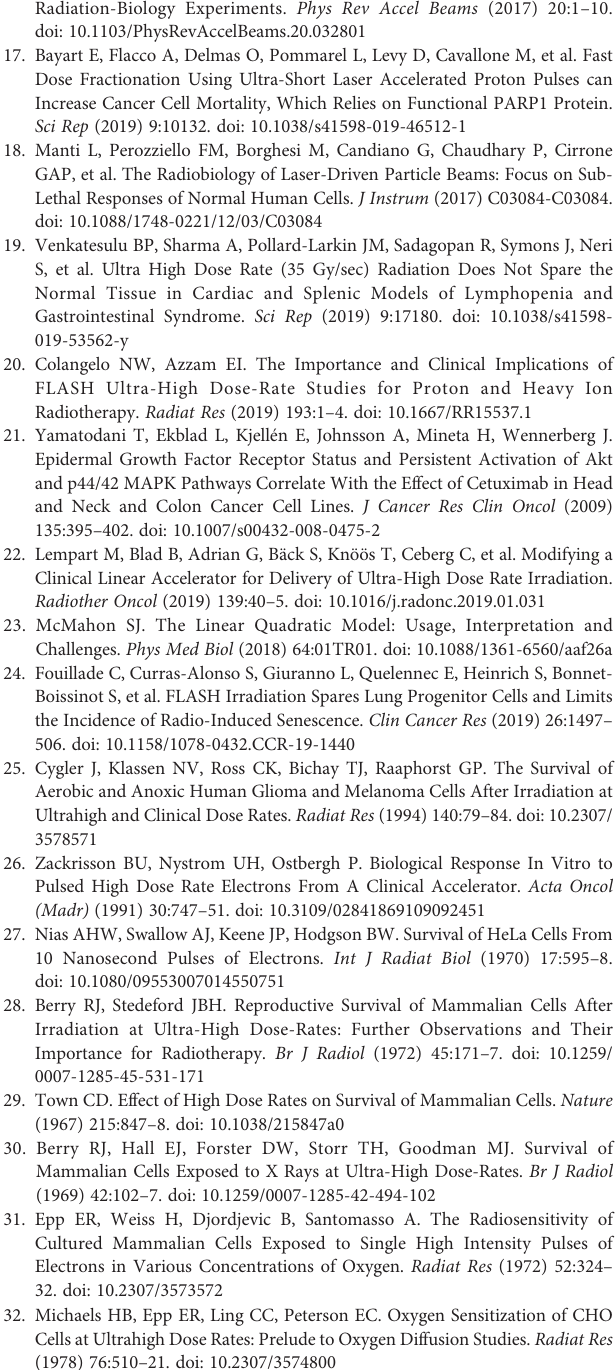
Supplementary Figure 1 | Cell cycle distributions determined by fl ow cytometry after irradiation with FLASH or conventional dose rate (CONV) for the HeLa subclone cell line 24 h after irradiation with 6 Gy. The S-phase was sub-divided into S1 (early), S2 (middle) and S3 (late). Bars illustrate G1 (light grey), S-phase (grey), and G2/M (black). The fi gures in the bars denote the percentage of cells (with standard deviations). Data from two independent